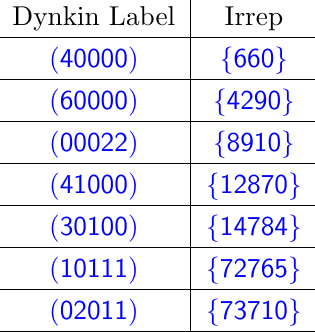
Table 7 . Summary of bosonic super(cid:12)elds that contain only one conformal graviton at